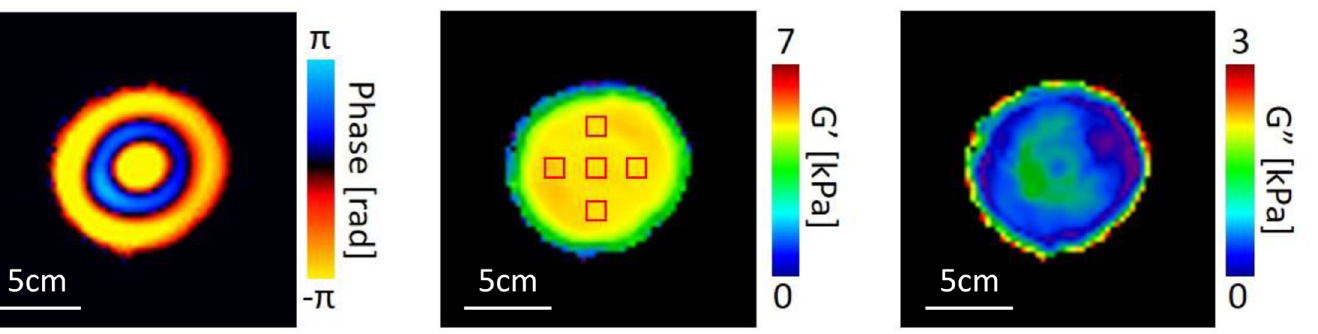
Fig 1. Magnetic Resonance Elastography (MRE) images. Left: Wave image, Center: Storage modulus (G’) map, Right: Loss modulus (G”) map. The five squares on the storage modulus map indicate ROIs.